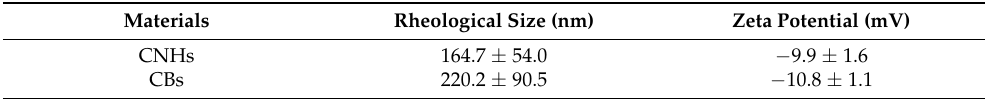
Table 1. Rheological size and zeta